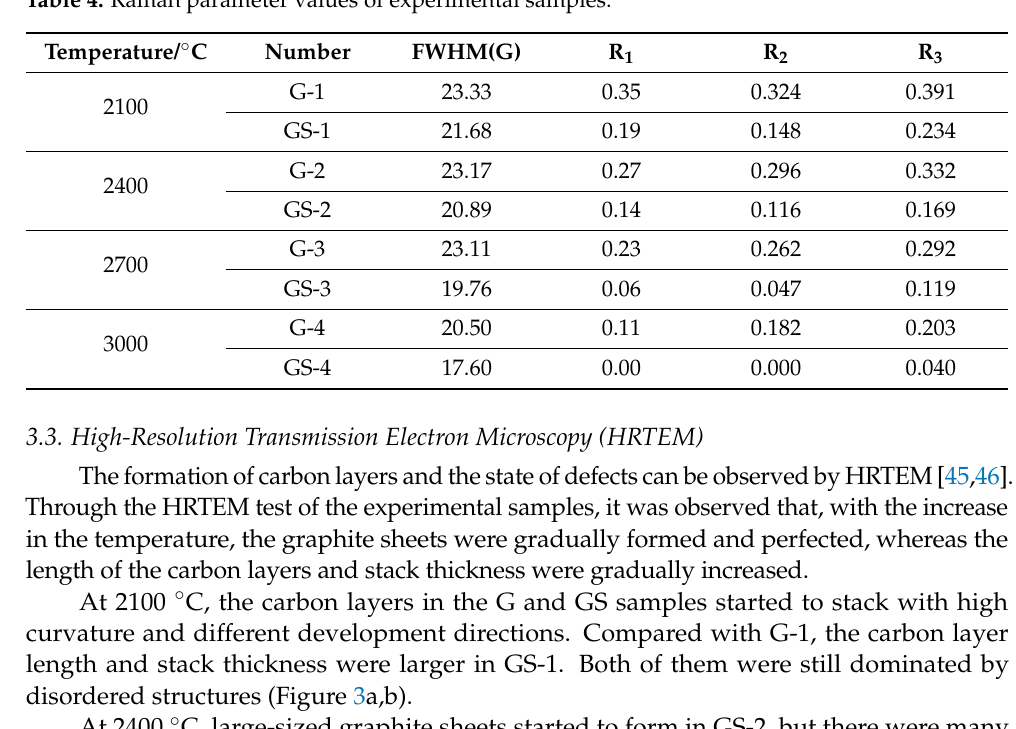
Table 4. Raman parameter values of experimental